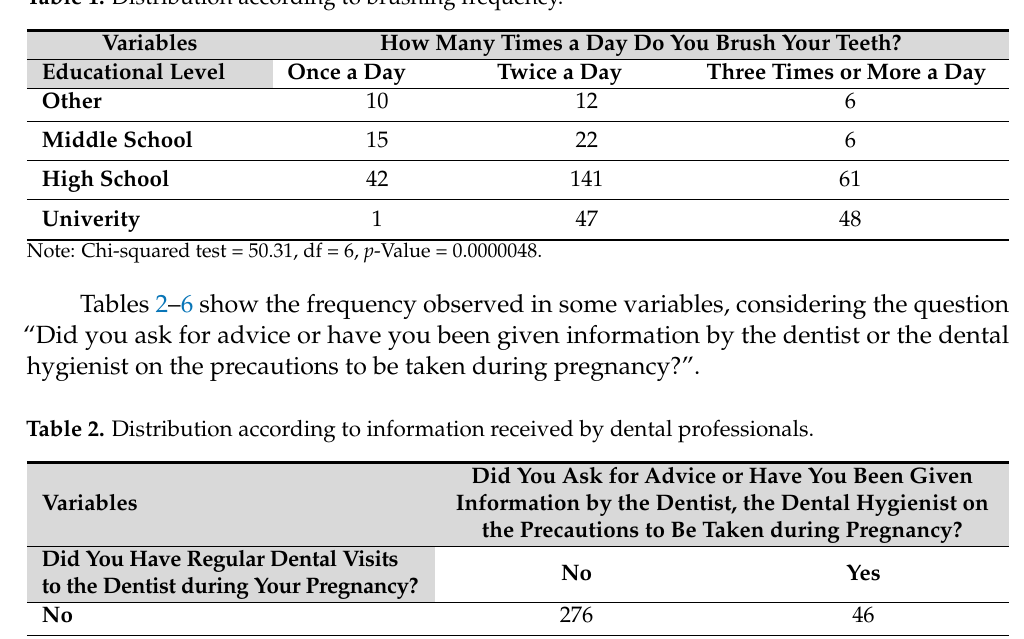
Table 1. Distribution according to brushing frequency.